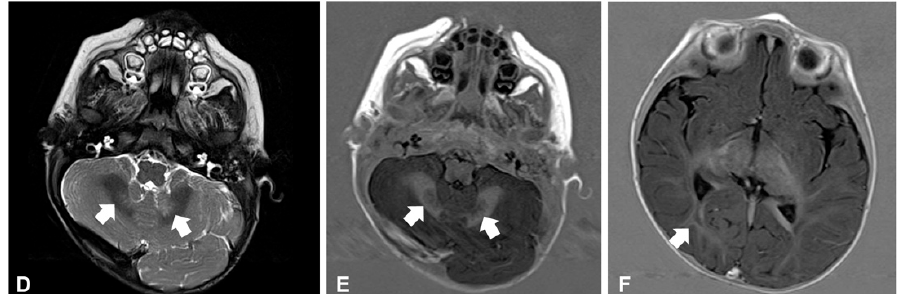
Figure 2. Brain magnetic resonance imaging in patient 1 at age 10 months. Corpus callosum is thin and mildly dysplastic at the level of isthmus (arrow in ( A ), sagittal view, T1-weighted image). The deep and periventricular white matter appears hyperintense compared to the grey matter (arrows in ( B ), axial view, FLAIR image), a similar abnormal high signal also involves the optic radiations (arrow in ( C ), axial view, FLAIR image). Finally, mild hyperintensity of the cerebellar dentate nuclei is visible (arrows in ( D ), axial view, T2 weighted image). T1-IR images confirm the involvement of dentate nuclei (arrows in ( E ), axial view) and optic radiations (arrow in ( F ), axial view).